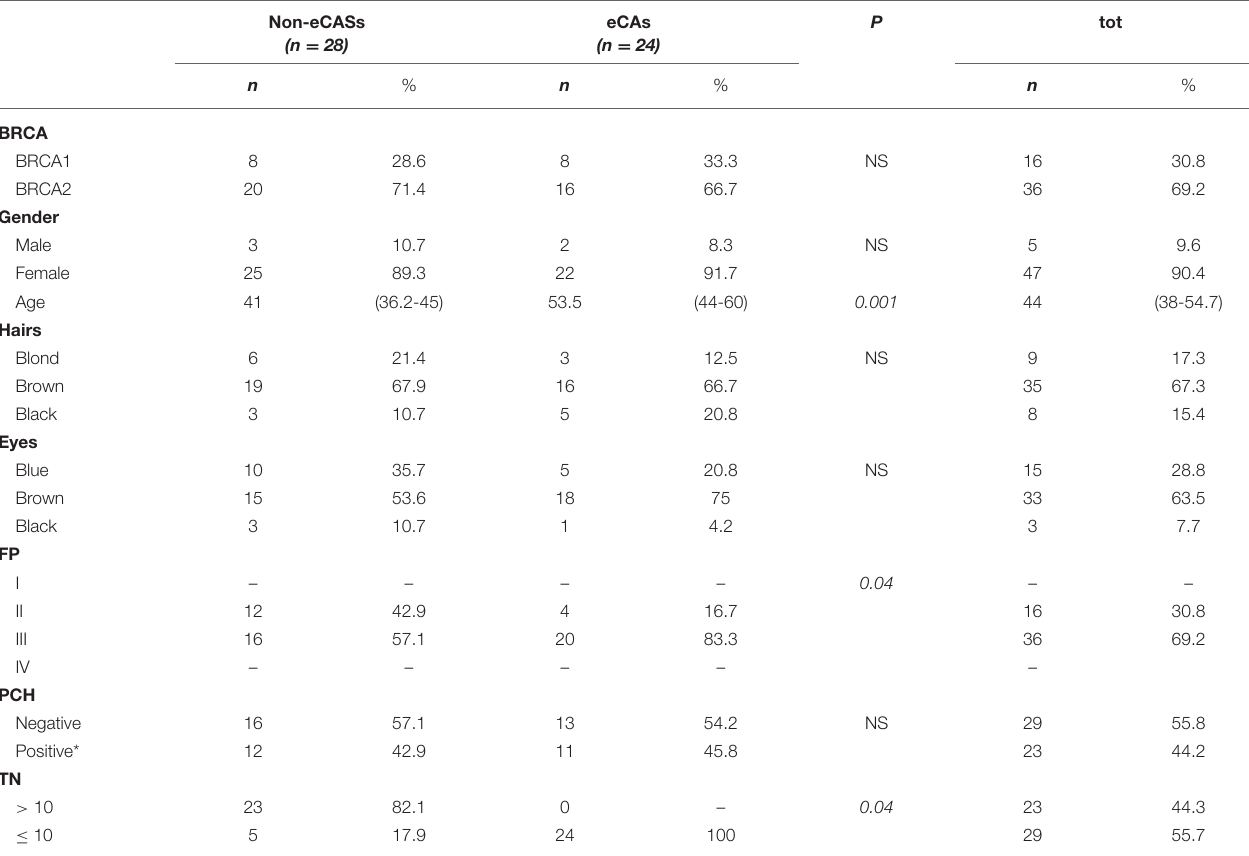
TABLE 2 | Analysis according to the presence or absence of eruptive cherry angiomas. Non-eCASs (n =